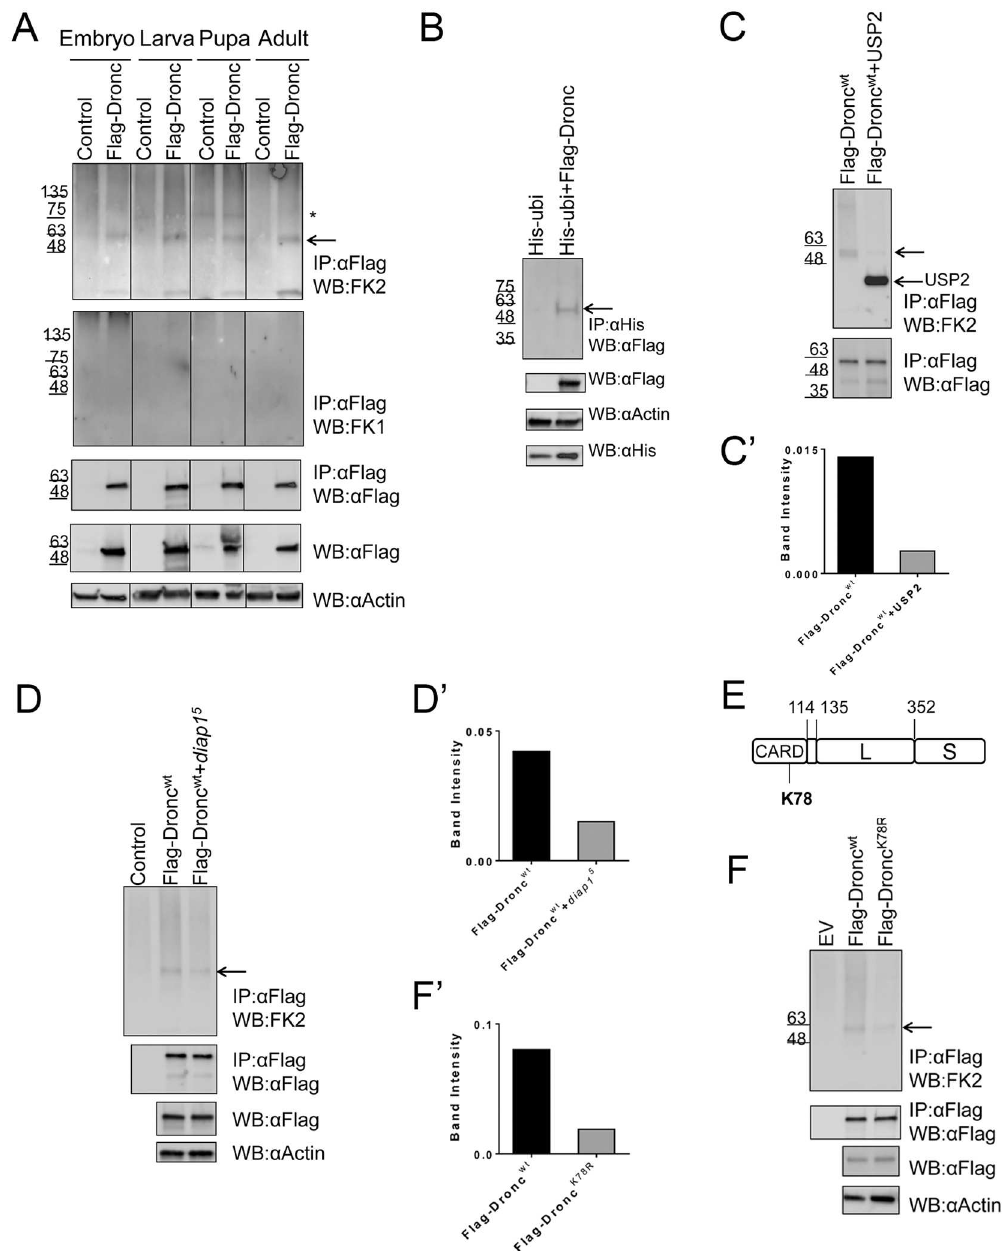
Fig 1. Dronc is mono-ubiquitylated at K78 in living cells for its inhibition. Arrows indicatemono-ubiquitylated Dronc. Asterisks denote unspecificbands. The Flag-Dronc transgene in (A) and (B) is describedin [47]. The transgenes used in (C)-(F) and all other figures were generated in this study. (A) Immunoprecipitateswith Flag antibody from da > Flag - Dronc extracts of the indicateddevelopmental stages were examinedfor Flag-Dronc ubiquitylation with FK2 and FK1 antibodies. ( B ) Extracts from da > Flag - Dronc+6xHis-ubiqitin larvaewere used to pull down 6xHis-taggedubiquitylated proteins. Flag antibodywas used to detect Flag-Dronc. (C,C’) USP2 de- ubiquitinase can remove the conjugated mono-ubiquitinon Flag-Dronc. (C’) is the quantification of the Flag-Dronc bandsin (C). The FK2 signal in (C’) is normalized againstimmunoprecipitated Flag-Dronc. The removal of mono- ubiquitin does not cause a significantchange in MW of Flag-Dronc. (D,D’) Heterozygous diap1 5 mutants display reducedFlag-Droncmono-ubiquitylation (quantifiedin D’). The loss of mono-ubiquitindoes not significantly change the MW of Flag-Dronc. ( E ) Domainstructure of Dronc, showingrelative positionof K78 in the CARD domain. L = large subunit; S = small subunit. ( F,F’ ) Flag-Dronc K78R mono-ubiquitylation is significantly reducedcomparedto Flag-Dronc wt . (quantifiedin F’). The loss of mono-ubiquitindoes not significantly changethe MW of Flag-Dronc K78R .